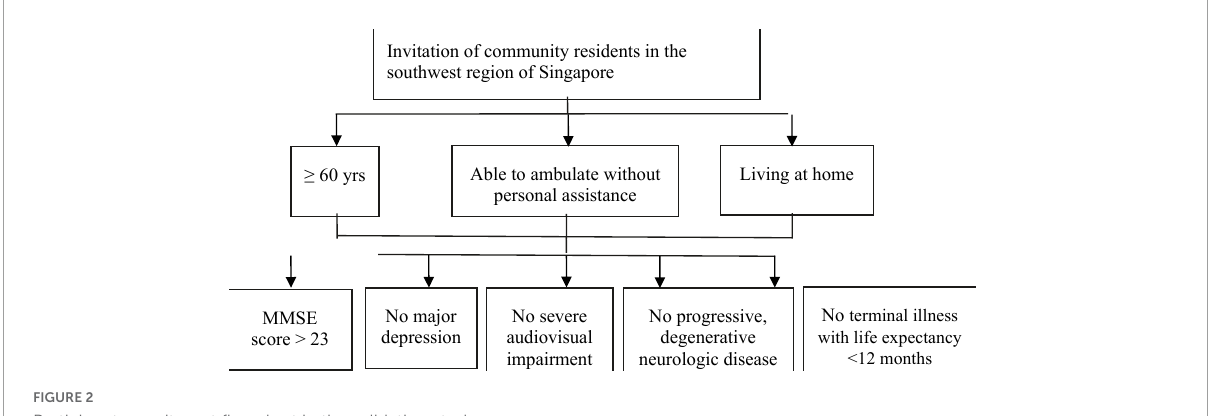
FIGURE2 Participant recruitment flowchart in the validation study.